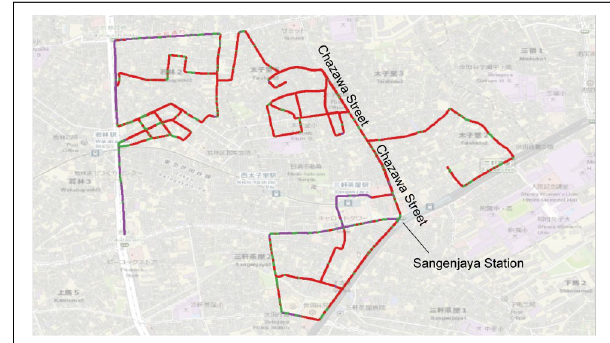
Figure 5. Result of regional classification using